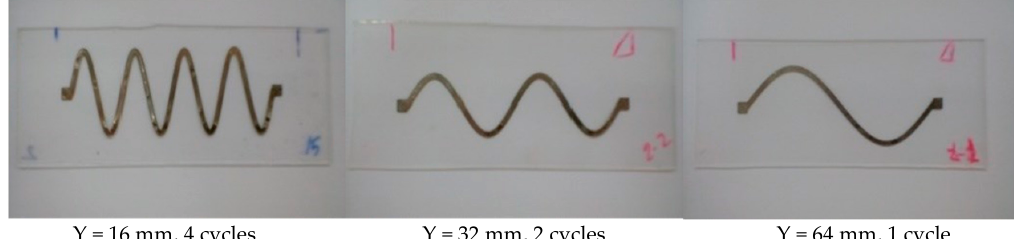
Figure 11. Sinusoidal conductive patterns printed on PDMS at various numbers of cycles.